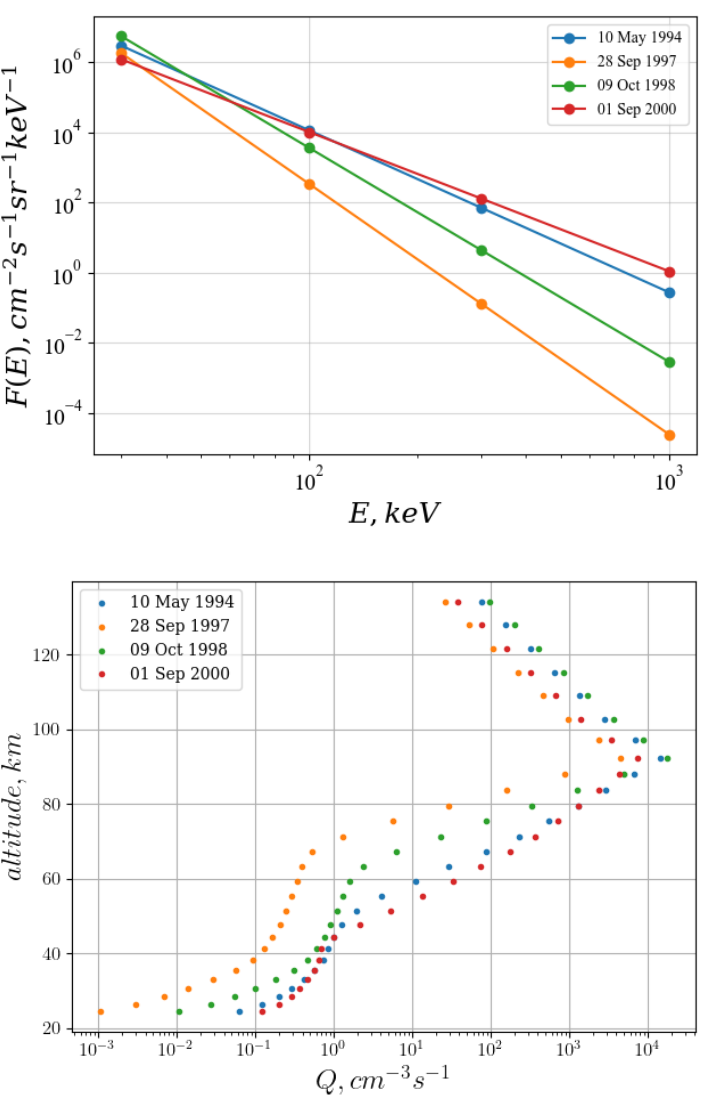
Figure 1. Upper panel: Energy spectra of precipitating energetic electrons obtained from balloon observations. Low panel: Altitude profiles of the ionization rates over Apatity (67.57 N, 33.56 E, L = 5.3) during geomagnetic disturbances with Kp = 4.